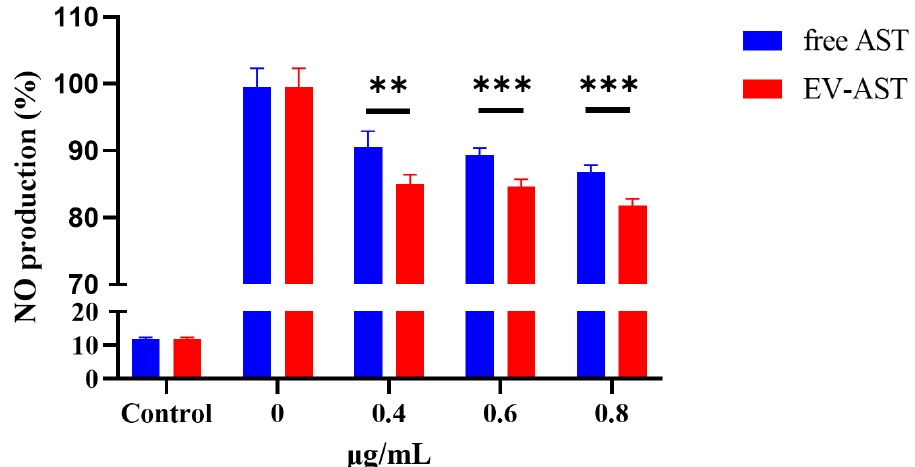
Figure 7. Measurement of the anti-inflammatory activities of free AST and EV ASTs. The anti- inflammatory activities of free AST and EV-ASTs (0.4, 0.6, and 0.8 µ g/mL) were determined in LPS-stimulated RAW 264.7 cells (**: p < 0.01; ***: p <